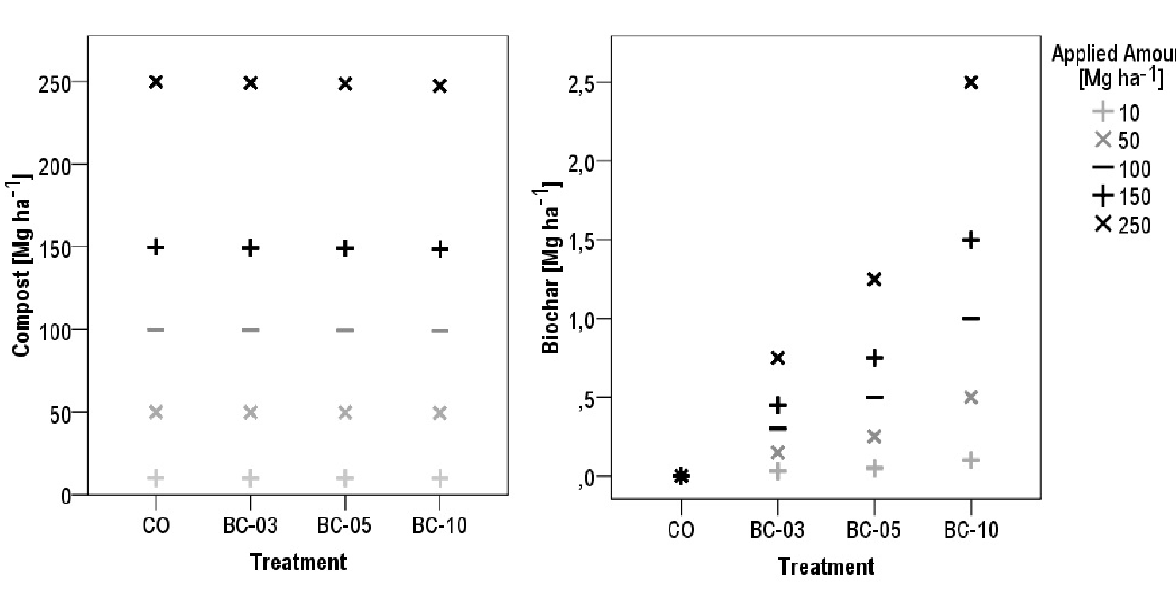
Figure 1. Individual amounts of applied compost and biochar (CO = pure compost, BC-03 = compost with 3 kg Mg −1 w / w biochar, BC-05 = compost with 5 kg Mg −1 w / w biochar, BC-10 = compost with 10 kg Mg −1 w / w biochar) at 5 application amounts (10,